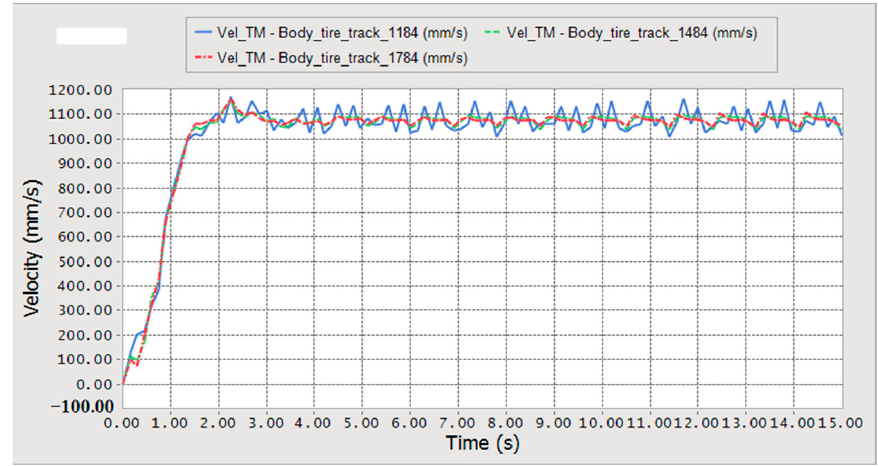
Figure 12. Walking speed with different eccentricities.